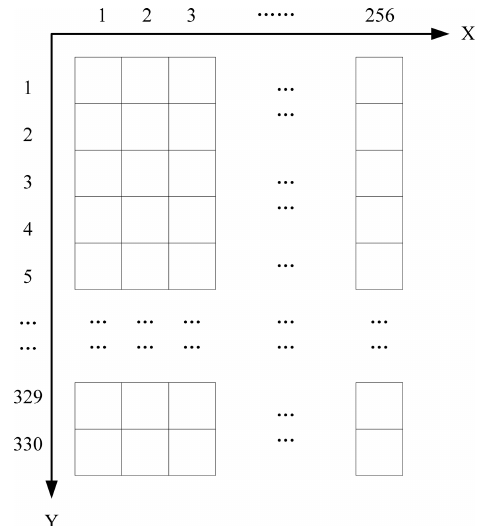
Figure 3. Detector array diagram of GIIRS. Table 7. Statistics of multi-star data for GIIRS.